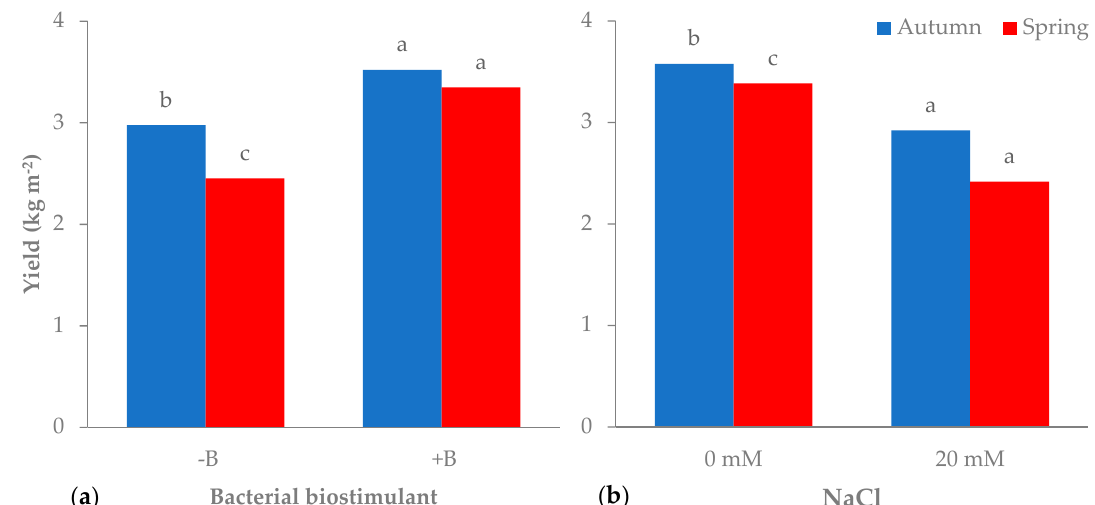
Figure 6. Yield of leaf lettuce plants grown during autumn and spring in nutrient solutions ( a ) with (+B) or without (-B) bacterial biostimulant or ( b ) containing different levels of NaCl (for each interaction, bars with different letters are significantly different at p < 0.05 according to the LSD test).